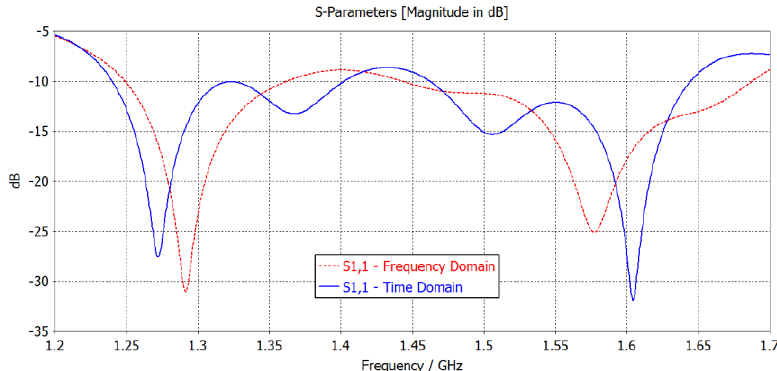
Figure 10. Design 1–8-element patch array: simulated reflection Figure 10. Design 1 – 8-element patch array: simulated reflection coefficient.